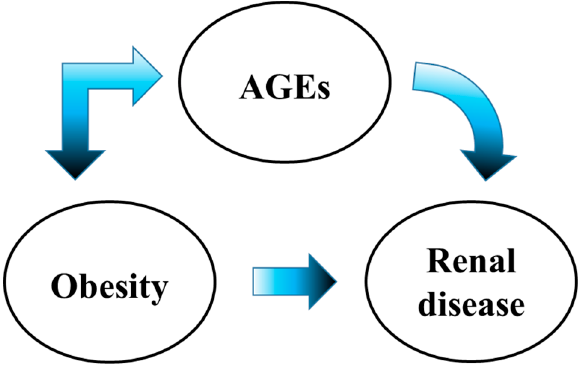
Figure 2. Schematic representation of advanced glycation end-products (AGEs) induced pathogenesis.